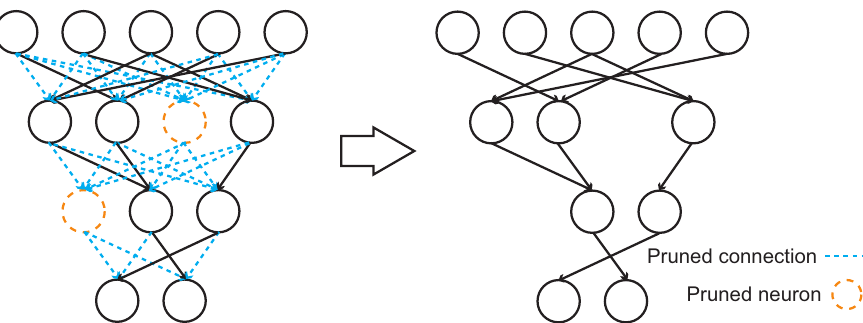
Figure 3. The weight pruning process. The connections (left side in blue color) among neurons with small weight values will be eliminated. The neurons (left side in orange color) without any input or output connection will also be